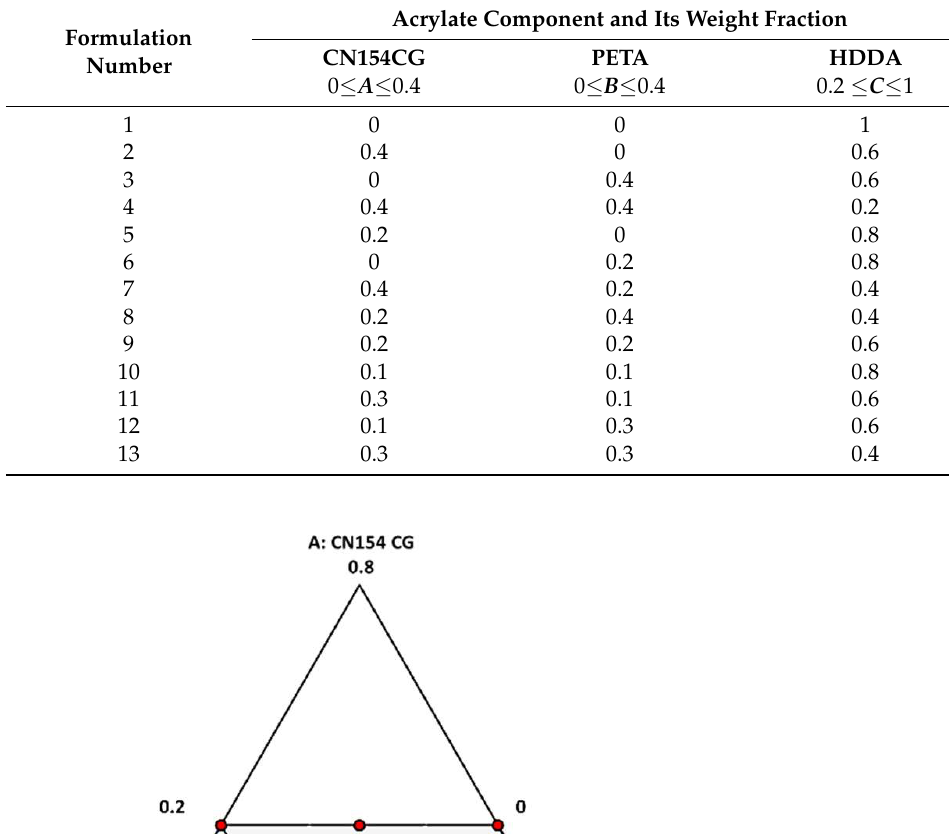
Table 2. Our uniform experimental design scheme for the preparation of resins. Formulation